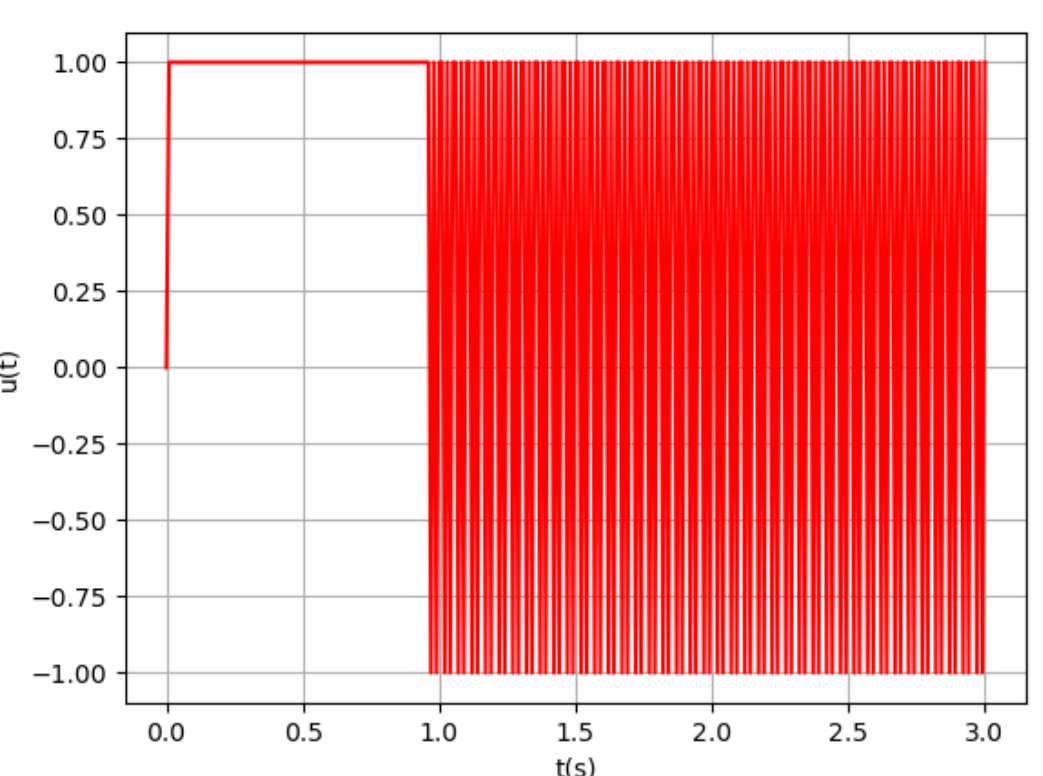
Figure 5. Resultant control signal: perturbed